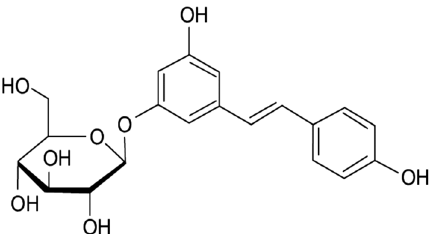
Fig. 21 Structure of polydatin (3,4 ′ ,5-trihydroxystilbene-3-β-D-